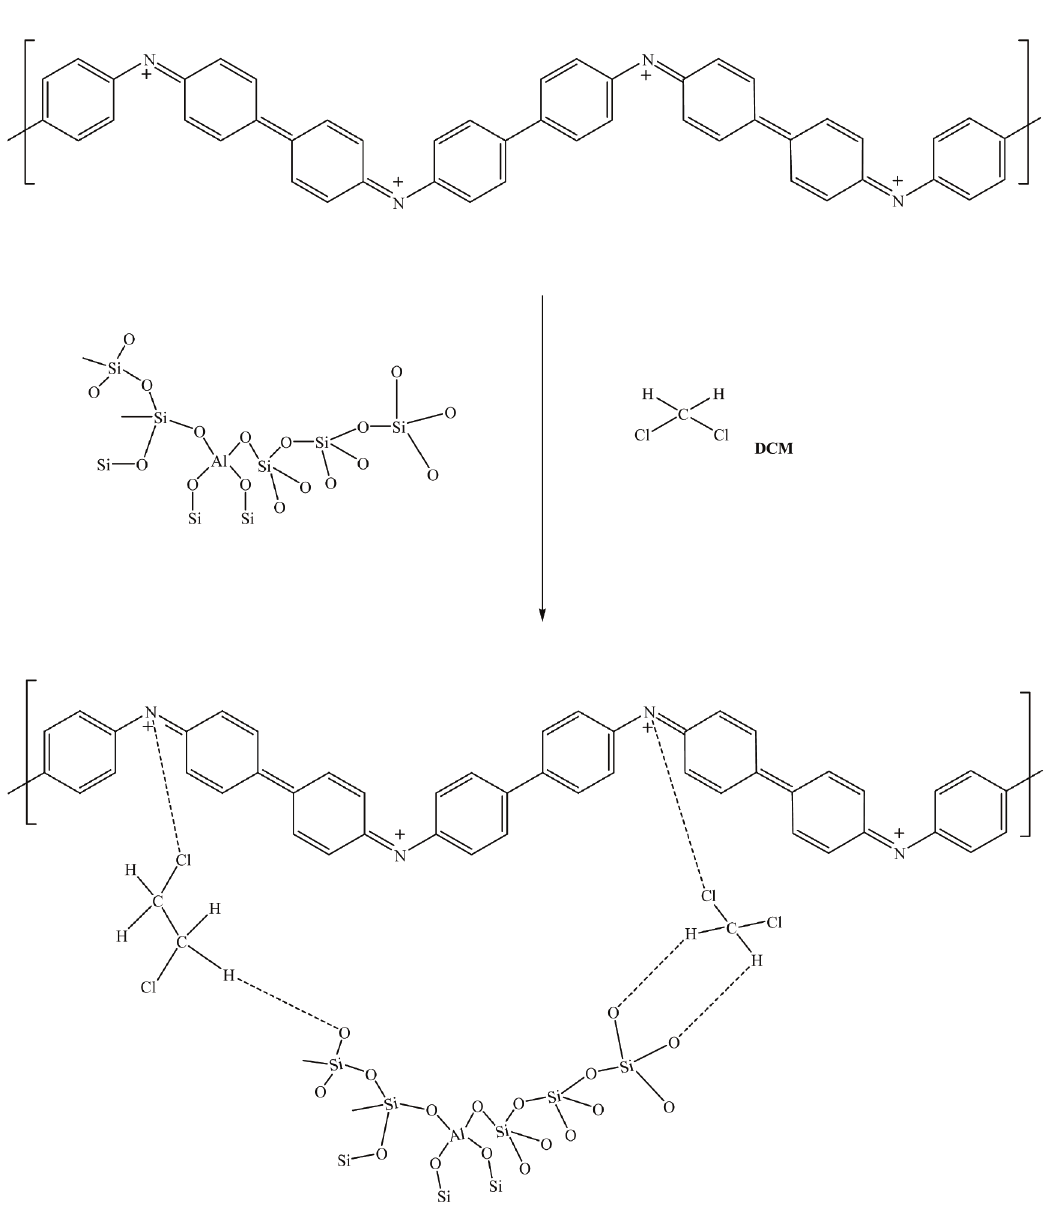
Figure 7. Proposed mechanism of adsorbed DCM, and DCE on D-PDPA/30% Y_H +